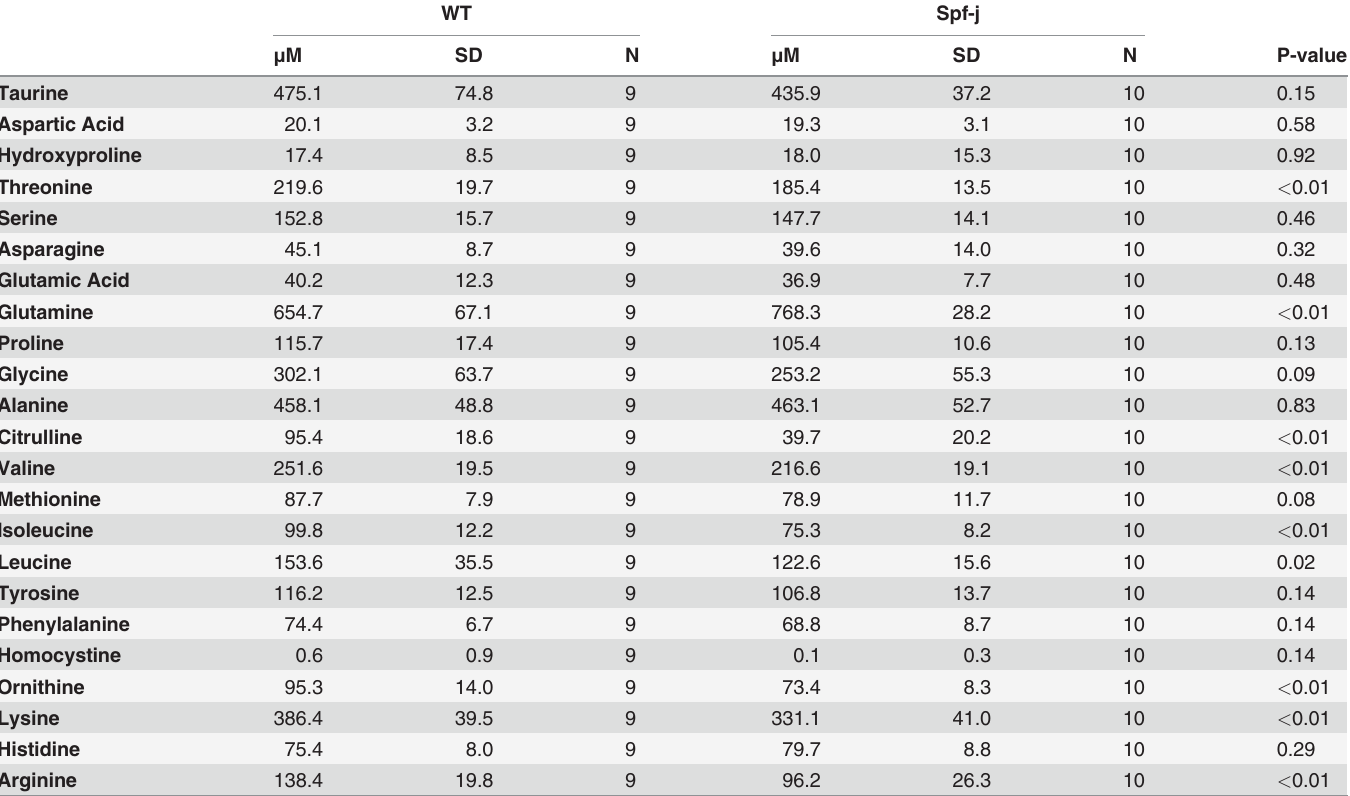
Table 1. Plasma amino acid concentrations at